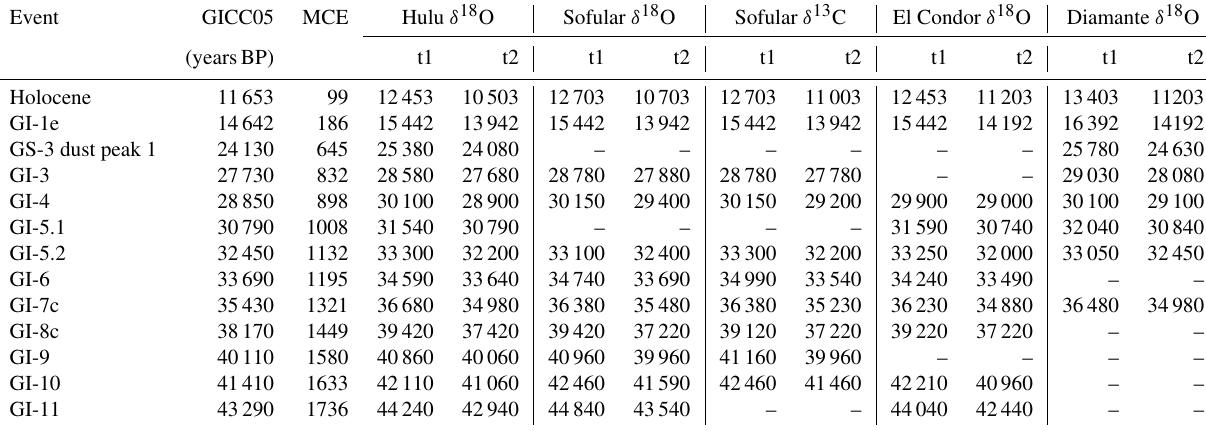
Figure 6. Effect of varying ages of soil respired CO 2 and fractions of CO 2 from 14 C dead carbonate on the (cid:49) 14 C in speleothems. (a) At- mospheric modeled (cid:49) 14 C from the 10 Be stack (black) and two modeled speleothem scenarios with a net DCF of 5.8% (warm colors) and 25.7% (cold colors). For each speleothem, a number of different ages for the respired soil organic matter have been assumed (see legend) and the input of 14 C-free CO 2 from carbonate has been adjusted to obtain the correct apparent DCF value between 39 and 40.5kaBP. (b) The inferred delay when we apply our synchronization method to match the atmospheric (cid:49) 14 C to the speleothem record. Table 1. Change-point detection window for each record. For each investigated climate event and record, the change-point detection algo- rithm has been applied between t1 and t2. The windows have been defined visually, ensuring a sufficient amount of data prior to and after the transition. For each record, only events that are well expressed in the climate proxy records at high resolution have been investigated. For the ice-core record, t1 and t2 typically encompass 500 years prior to and after the nominal transition ages by Rasmussen et al. (2014a). The exact values have been adjusted to exclude overlap with other transitions where necessary (Erhardt et al.,